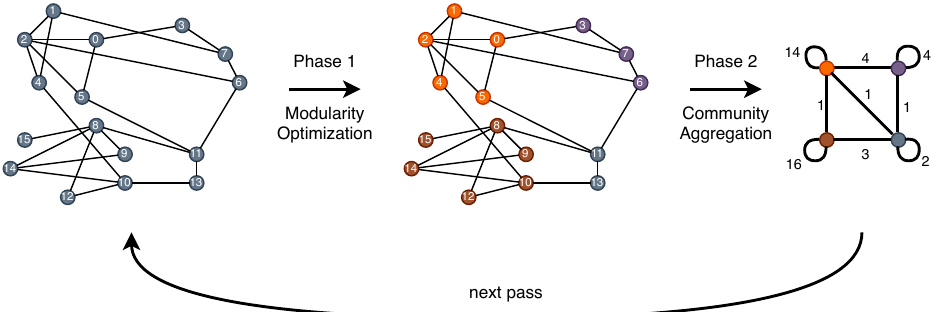
Figure 6. Steps of the Louvain algorithm, adapted from